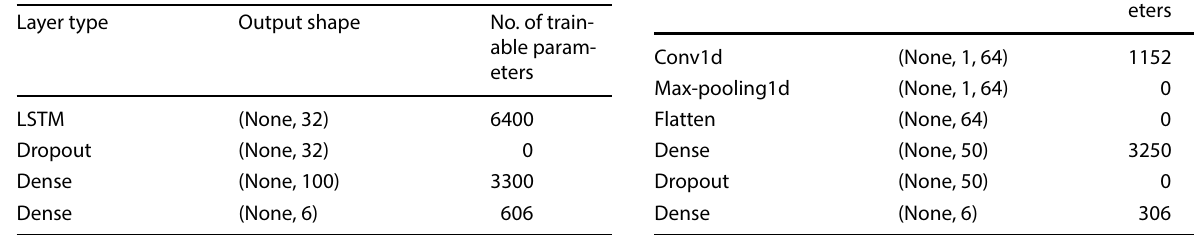
Table 4 LSTM network design